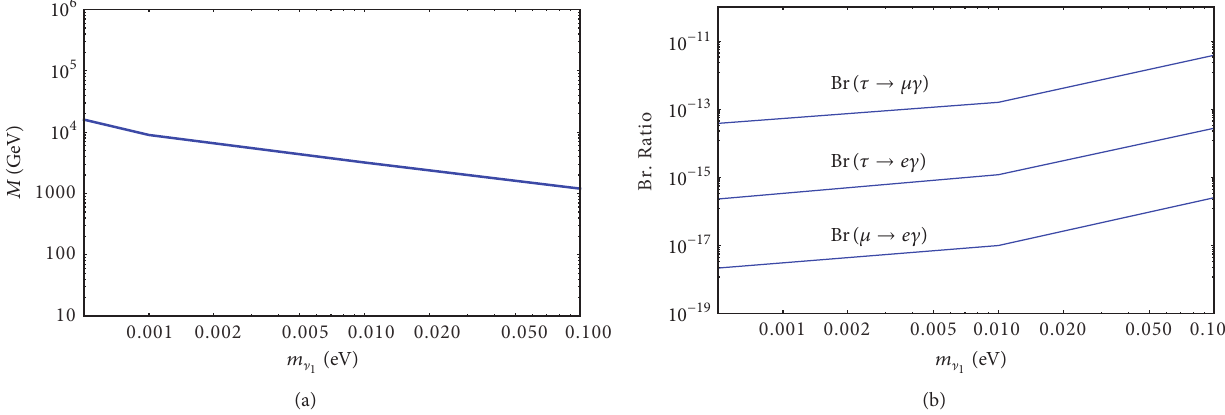
Figure 2: Same as Figure 1 but for extended inverse seesaw dominance. (a) represents variation of 𝑁 - 𝑆 mixing mass term 𝑀 as a function of lightest neutrino mass where we have followed normal ordering. The three lines in (b) represent the LFV branching